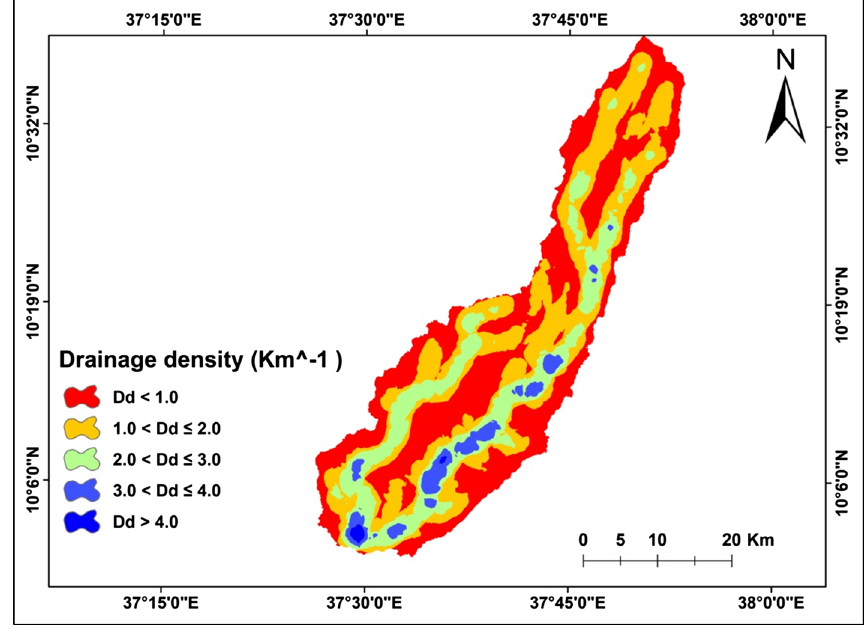
Fig. 4 Drainage density map of the study area